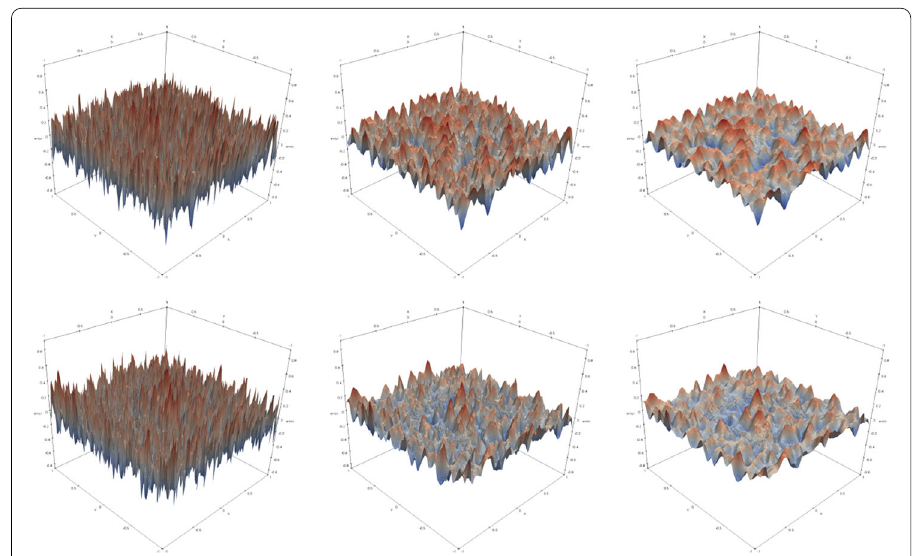
Fig. 3 Surface plots of iterates of a Gauß–Seidel smoother for iteration 1 , 3 , 5 (left to right) using a random initial guess on a blended discretization using a small (top) and a large overlap region